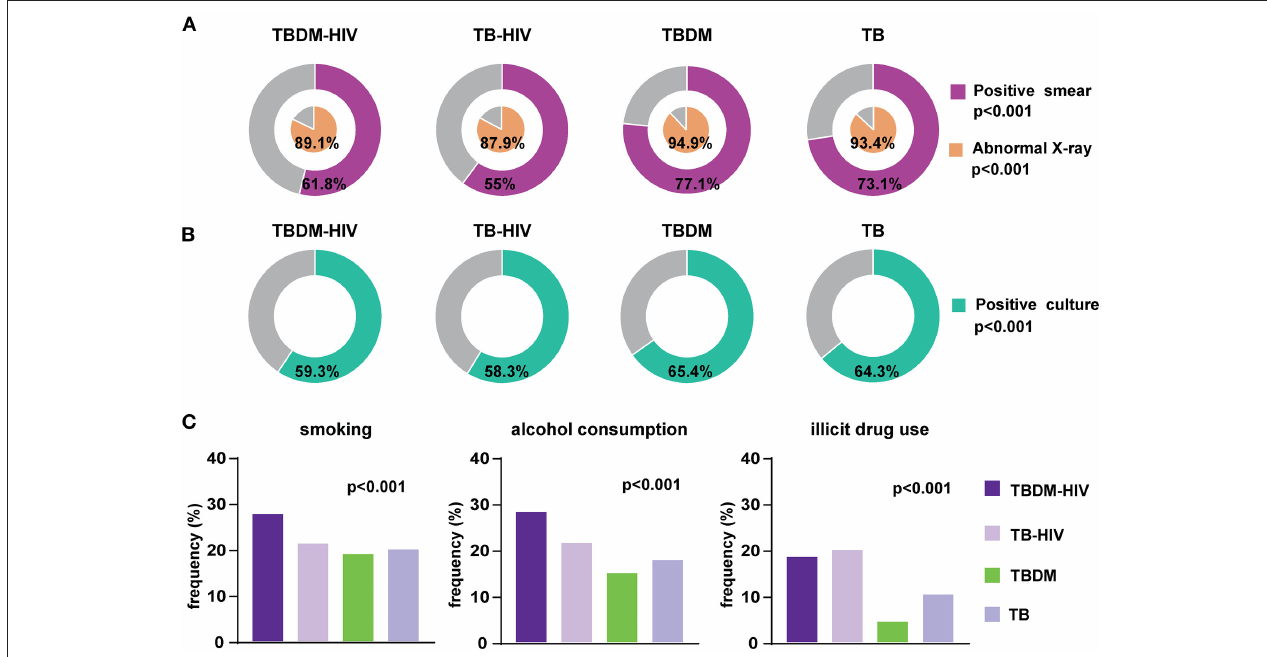
FIGURE 4 | Clinical Characteristics of people with TB according glycemic and HIV status of the SINAN cohort. (A) Proportion of positive smears and abnormal X-rays in each study group. (B) Frequency of positive cultures. (C) TB cases according glycemic and HIV status regarding smoking habit, alcohol consumption and illicit drug use (smoking, alcohol, and illicit drug: in the past or at the time of evaluation before anti-TB treatment). The data were compared between the groups using the Pearson’s chi-square test. Comparisons with significant p -values are displayed in bold. TB, tuberculosis; DM, diabetes; PDM,